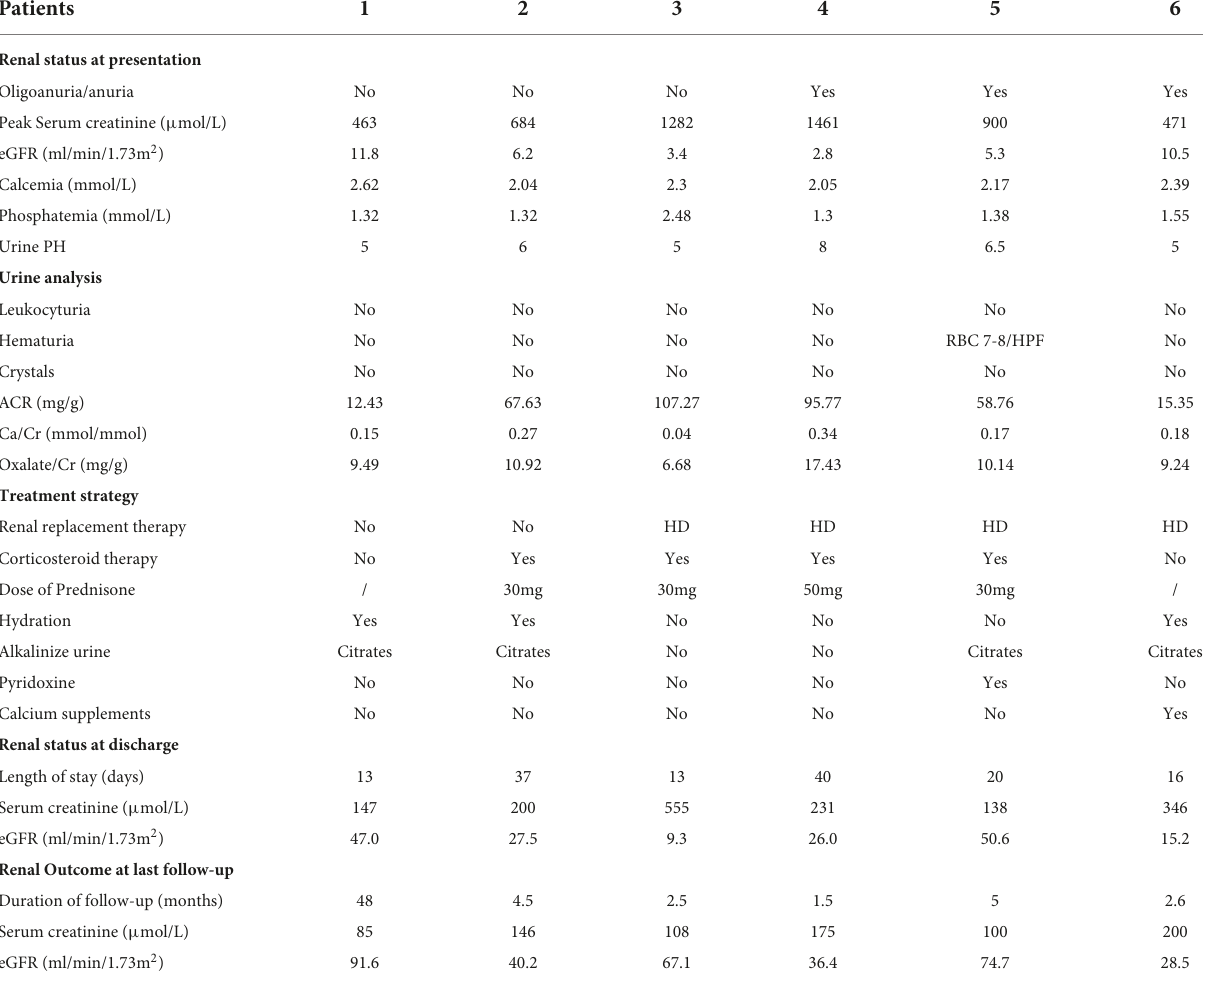
TABLE 2 Clinical presentation at admission, treatment strategy and disease course of the 6 patients with acute oxalate nephropathy.